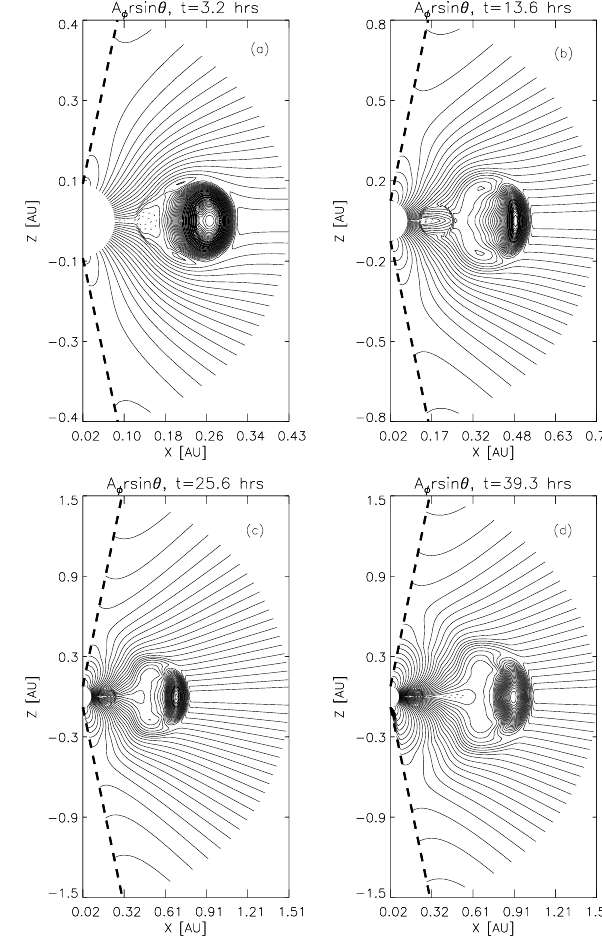
Fig. 9. As Fig. 9, except the ICME now encounters a current sheet at θ = 0. Above (below) θ = 0, field lines are directed away from (towards) the Sun. The ICME field has an anti-clockwise sense of